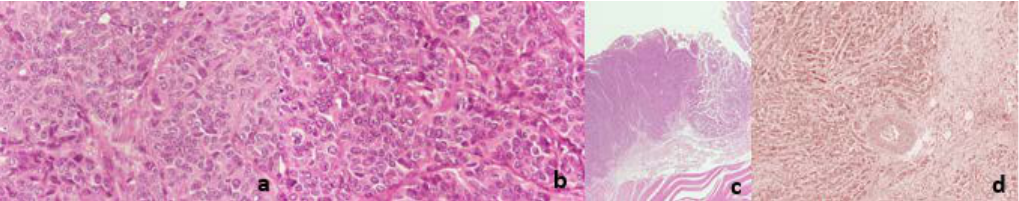
Figure 3. ( a ) (HE, 40 × ) Large tumor cells with irregular nuclei, finely granular chromatin, and indistinct nucleoli. ( b ) (HE, 40 × ) Tumor architecture includes organoid nests or trabeculi separated by thin fibrovascularseptae. ( c ) (HE, 2 × ) The exterior surface of the neoplasm shows ulceration. ( d ) (HE, 40 × ) Left side of the image shows infiltration of the neoplasm, meanwhile the right side shows involved pancreatic parenchyma.